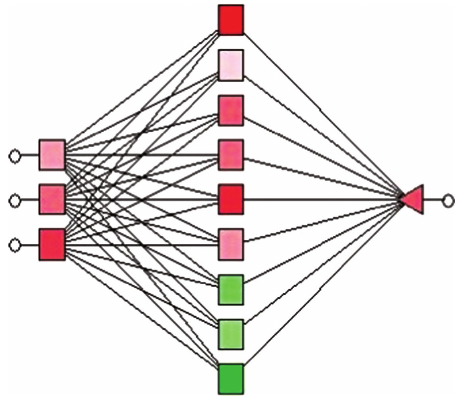
Figure 1 Multi-layer perceptron with one hidden